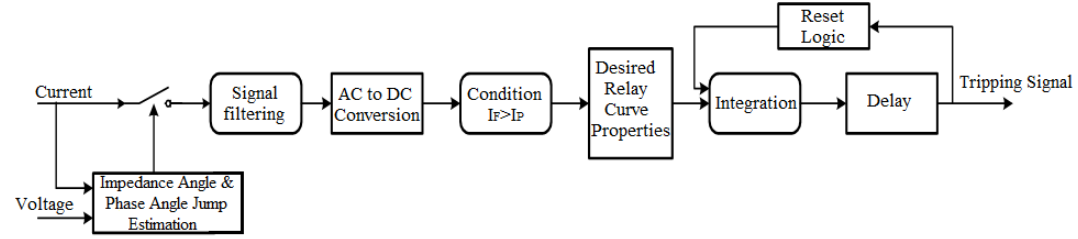
Figure 4. Conceptual diagram of digital directional over-current